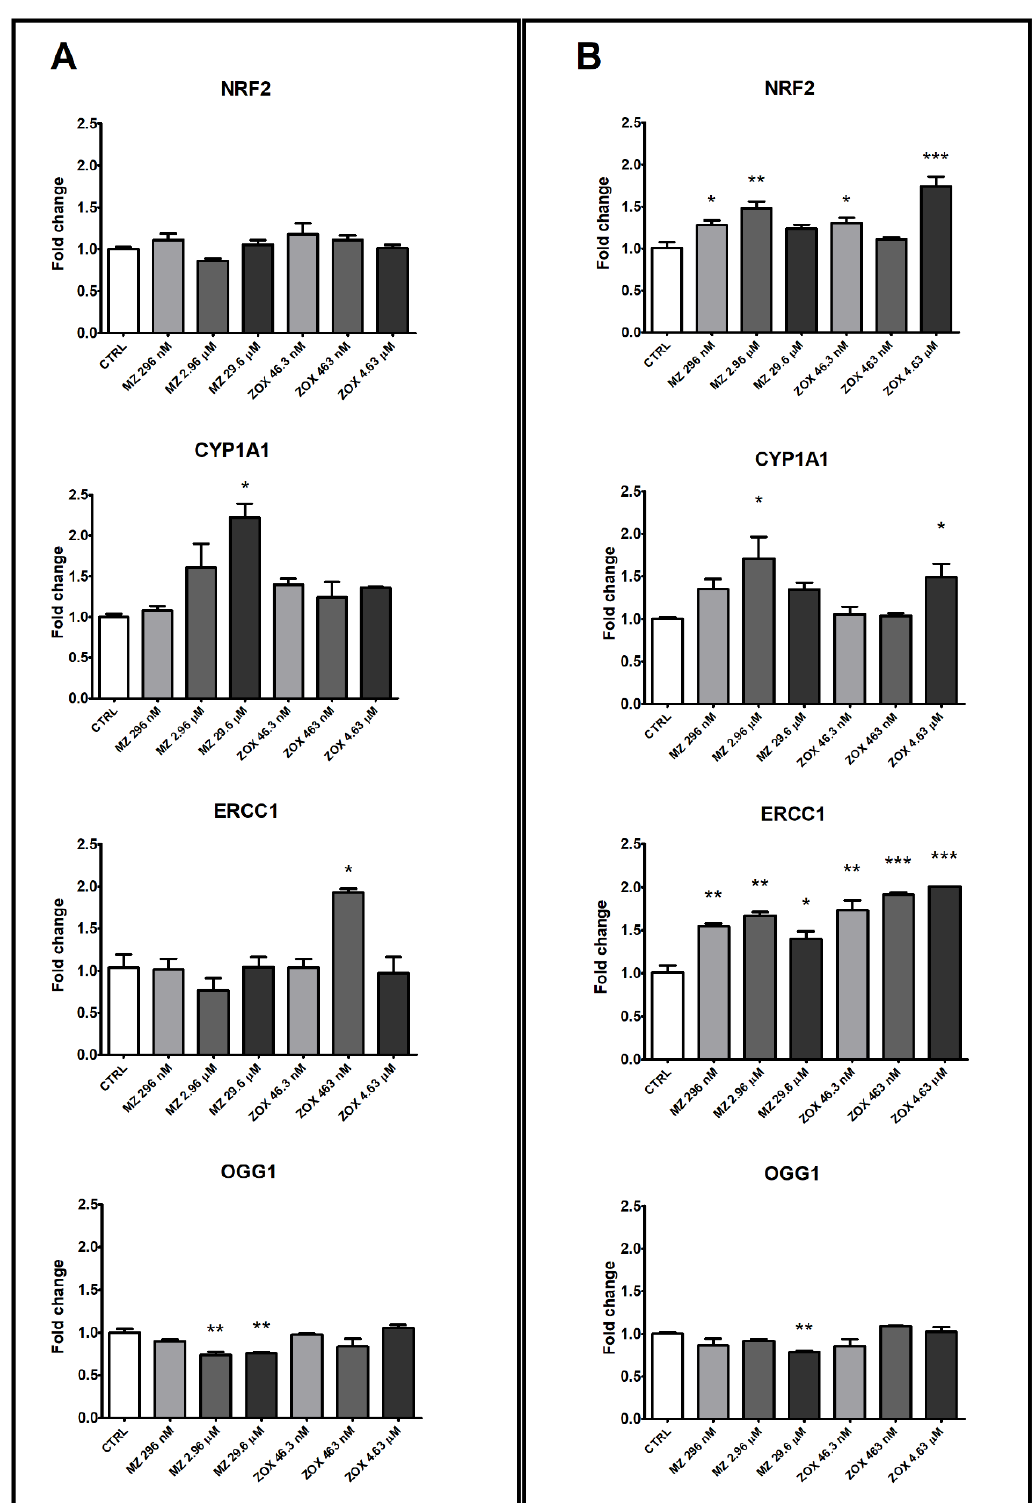
Figure 10. NRF2, CYP1A1, ERCC1 and OGG1 gene expression analysis by real-time PCR in HepG2 ( A ) and A549 ( B ) cells following treatment with MZ, ZOX or medium alone as control for 24 h. Data are mean ΔΔCt values ± SEM of three biological replica, with control samples as calibrators and GAPDH as the reference gene. Statistical significance is indicated by asterisks: * p < 0.05; ** p < 0.01; *** p < 0.001.